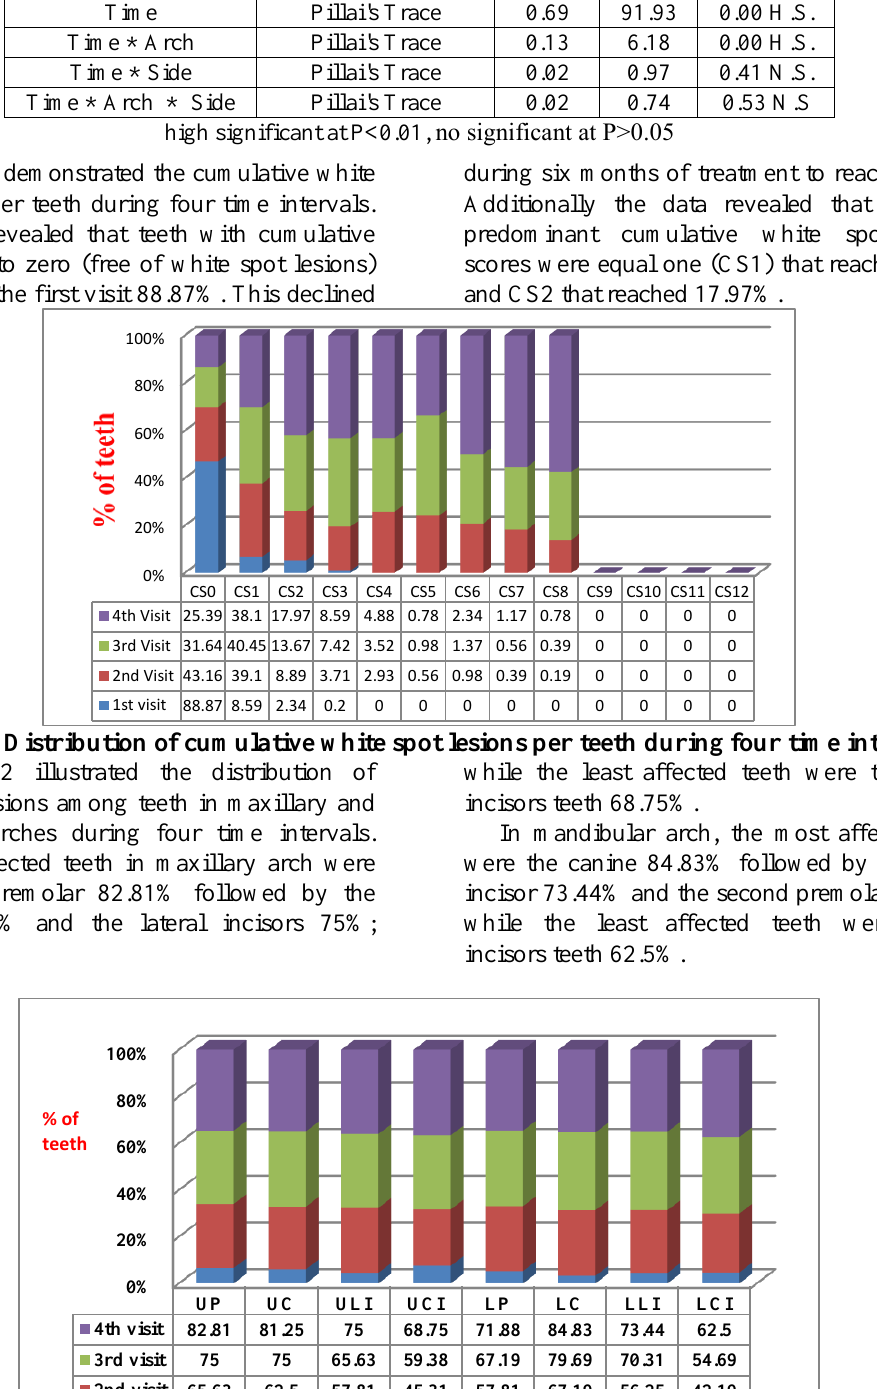
Table2: Effect of time, arch and sides of arch on cumulative white spot lesions